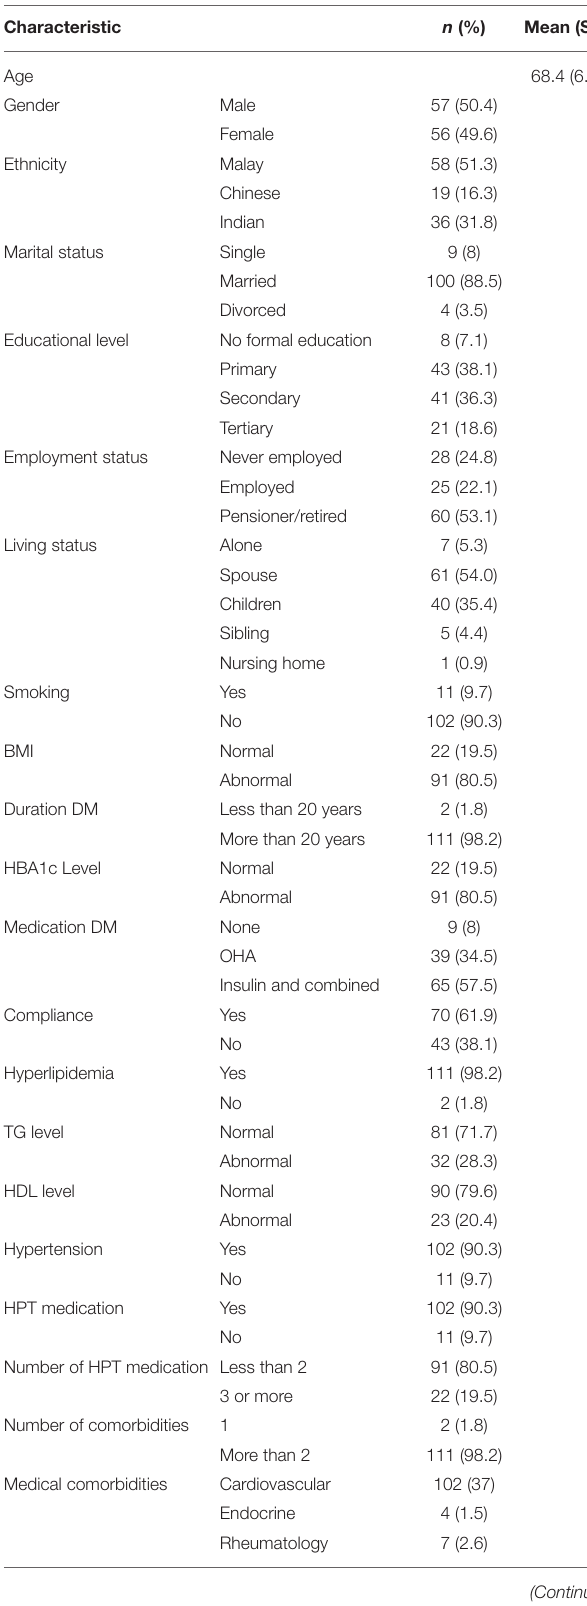
TABLE 1 | Sociodemographic and clinical data of participants ( N =